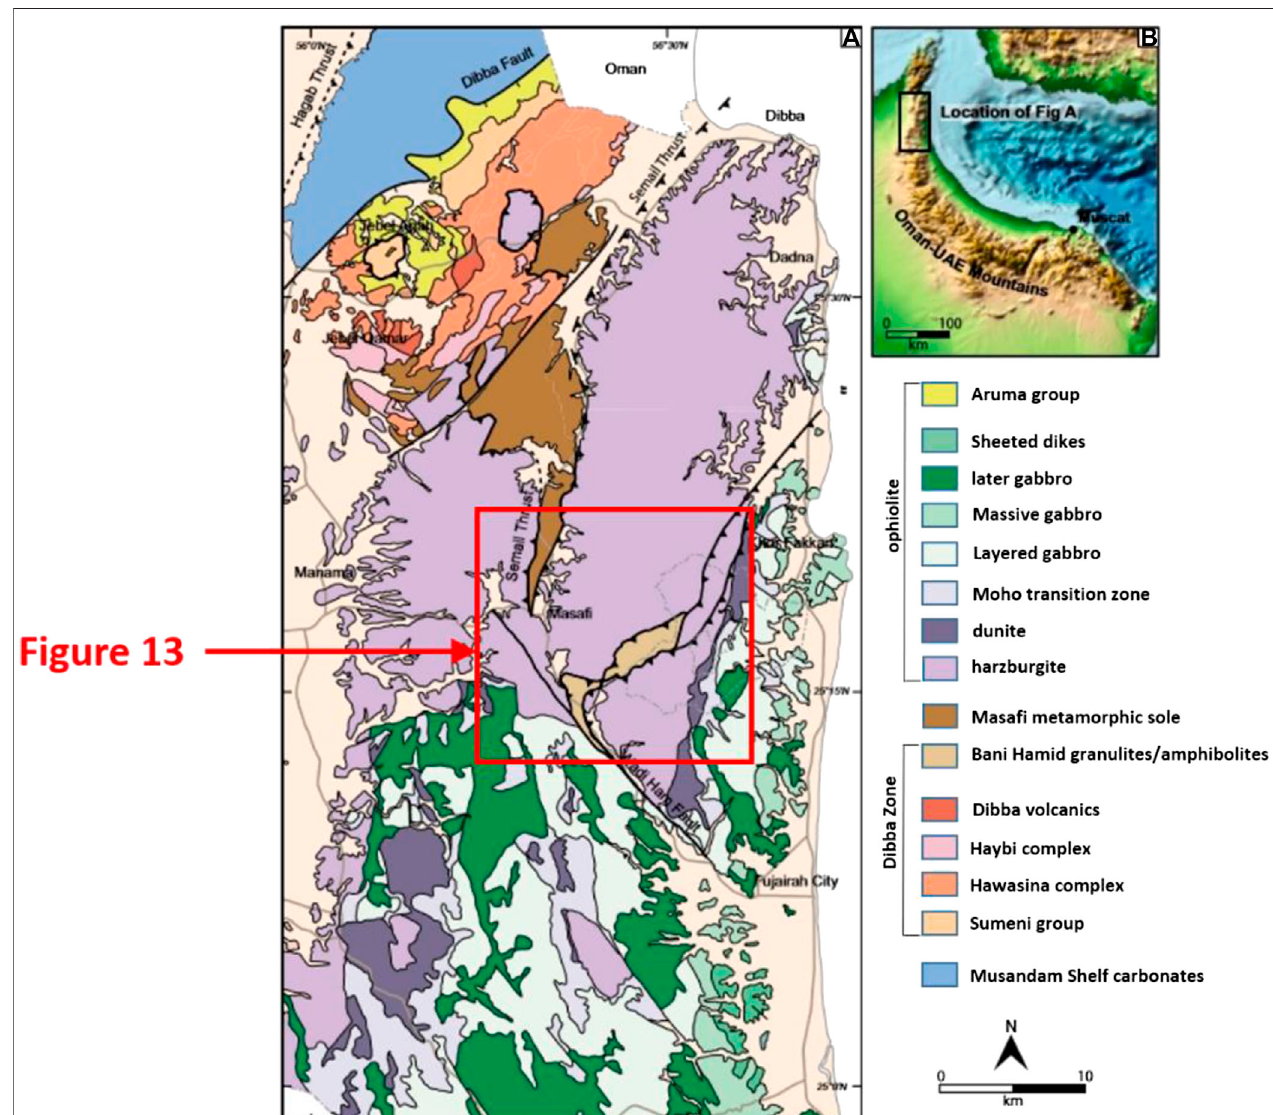
FIGURE 12 | Lithology and main geological features in study